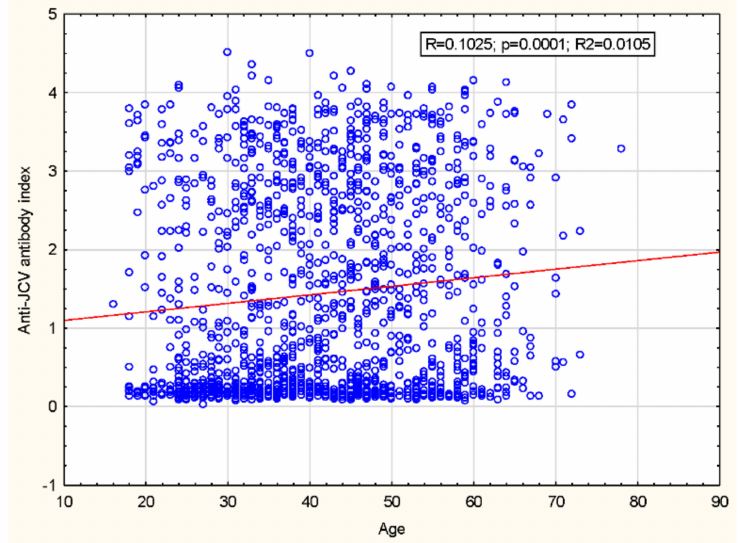
Figure 1. Correlation between anti-JCV Ab index and patient’s age. r = Spearman = 0.1025; p =